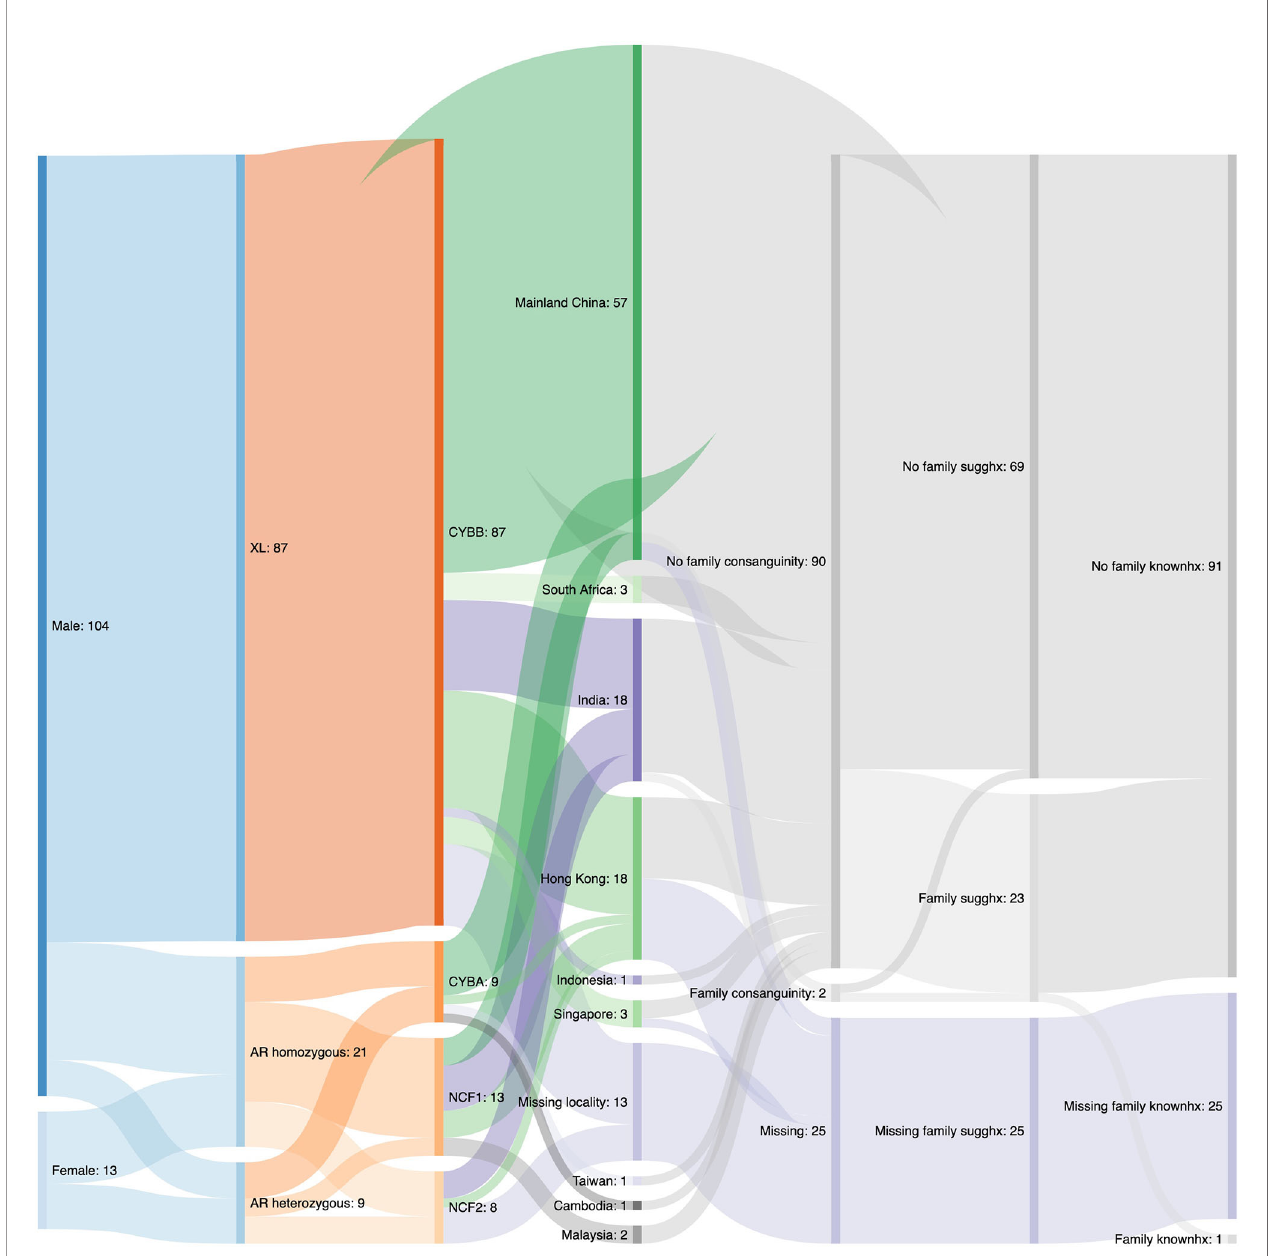
FIGURE 1 | A Sankey diagram describing demographics data of the CGD case series. XL, X-linked; AR, autosomal recessive; sugghx, suggested history; knownhx, known